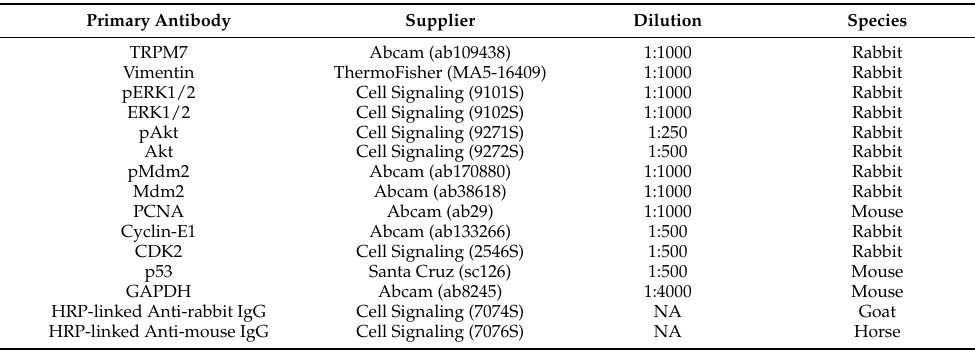
Table 1. Antibodies used in Western